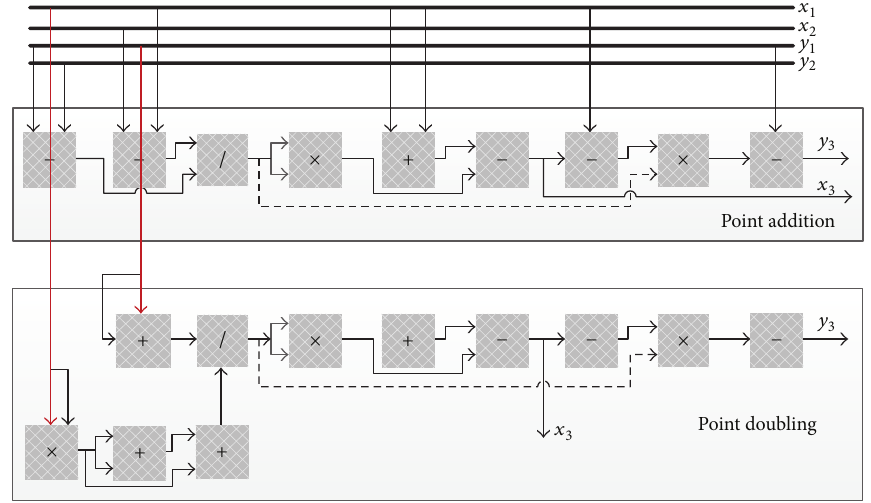
Figure 4: Scheduling of point